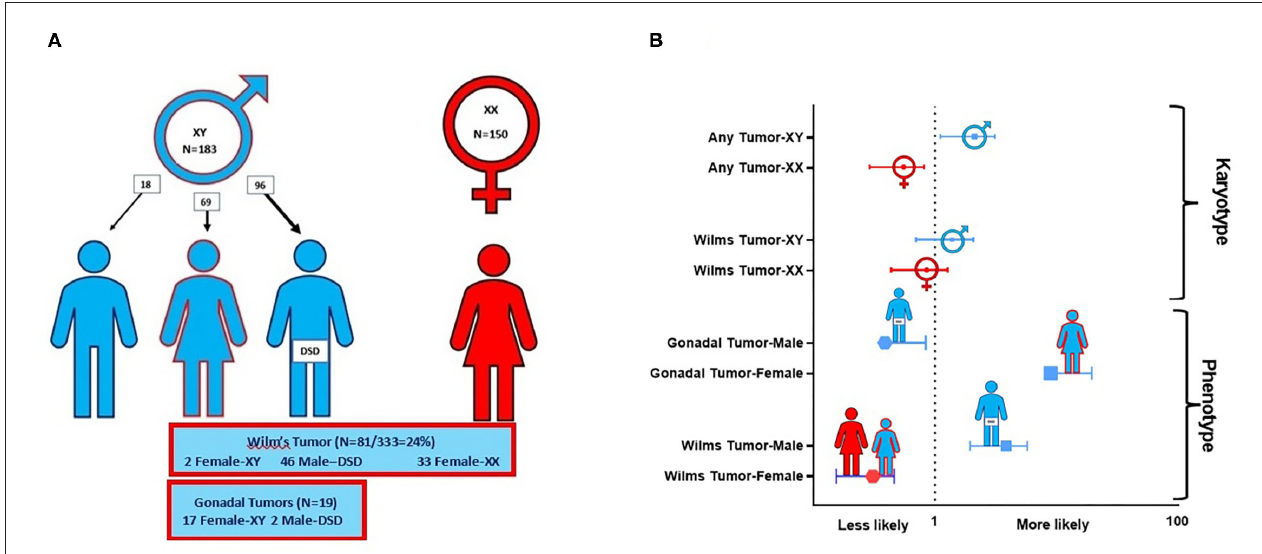
FIGURE 3 | This composite depicts the risks of malignancy in WT1 mutation according to phenotype and karyotype. (A) Distribution of karyotype and Wilm’s tumor and gonadal tumors in 333 cases of WT1 mutation. Note that the true male XY ( n = 18) without DSD developed no malignancy. Only those with XY karyotype and gonadal dysgenesis (male XY-DSD and female-XY) developed gonadal tumors. (B) Risks by odds ratios for developing Wilm’s tumor and/or gonadal tumor by karyotype and phenotype in 333 cases of WT1 mutation . For graphic clarity, the phenotype is represented by the male and female iconic figures in blue and red, respectively . The karyotypes are graphically represented by the male and female gender icons in blue and red, respectively